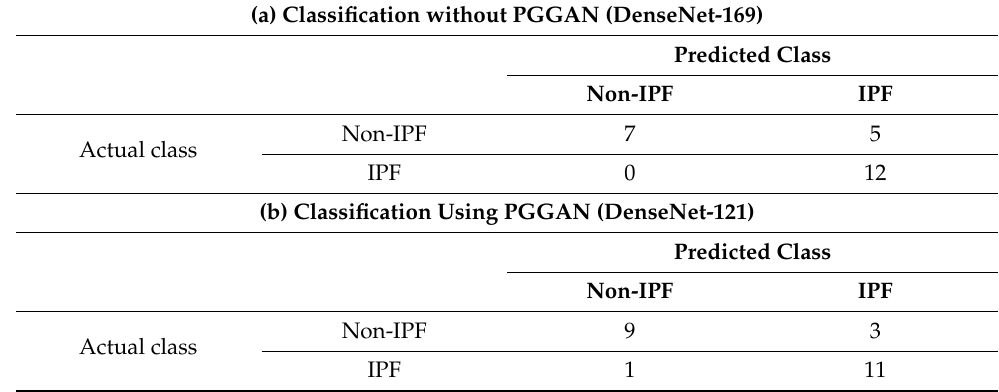
Table 2. Confusion matrix of classification (case-based